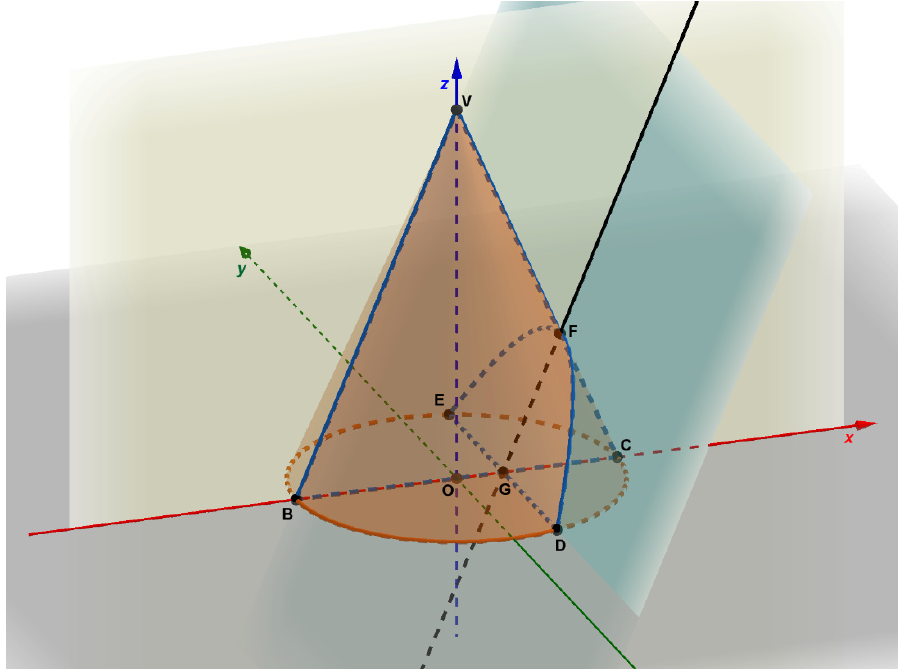
Figure 2. Same as Figure 1, with the addition of the plane whose intersection with the cone forms the parabola 𝐷𝐹𝐸 . parabola DFE .